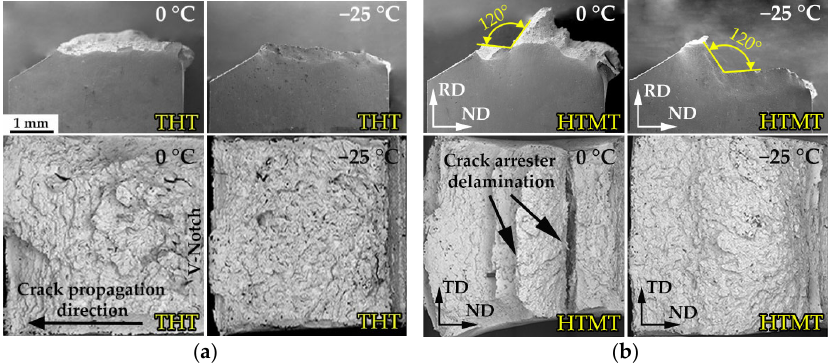
Figure 13. SEM images of the lateral and fracture surfaces of steel impact samples after THT ( a ) and HTMT ( b ) fractured at 0 and − 25 ℃ .